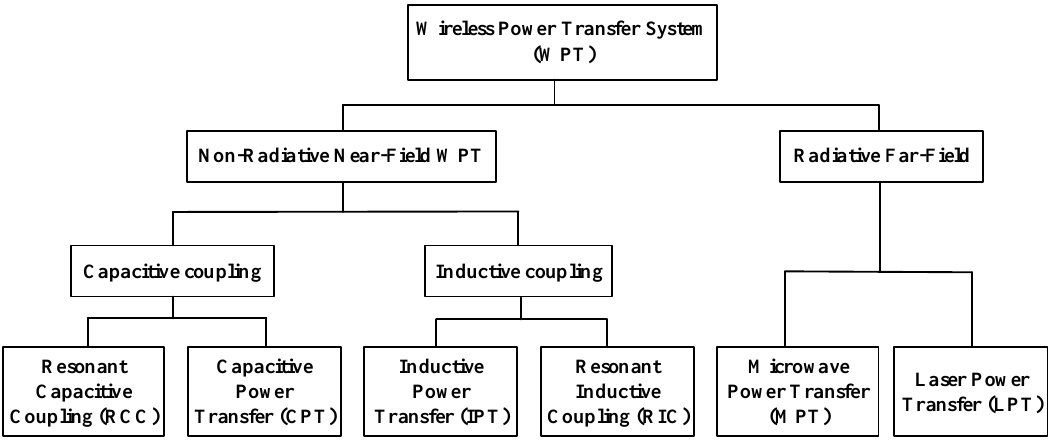
Figure 1. The classification of wireless power transfer (WPT)